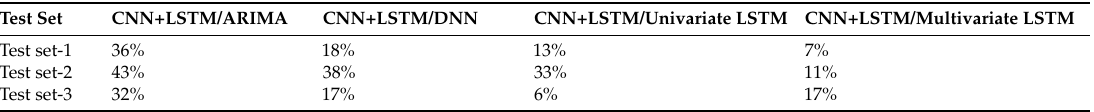
Table 5. Decrease percentage in RMSE of the proposed model compared to other models in each test set of “JingHai-VI”.